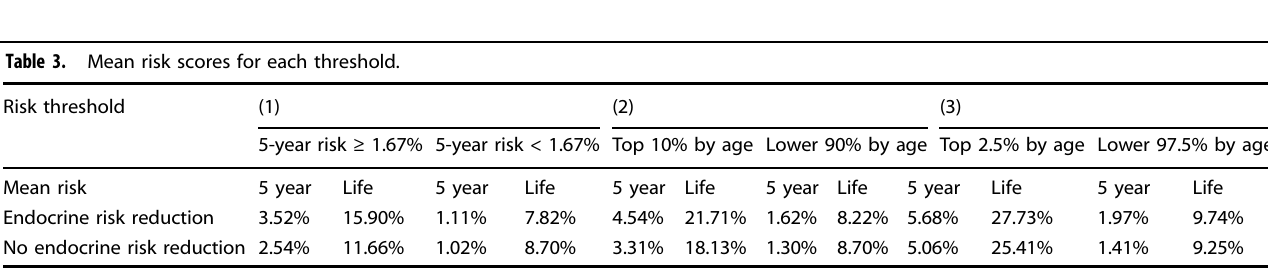
Table 3. Mean risk scores for each